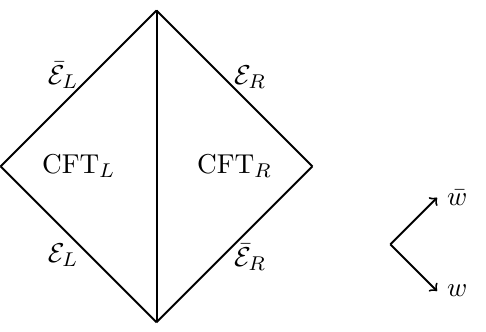
Figure 4 . The Penrose diagram associated to the defect CFT. Due to the non trivial gluing conditions, now E L and E R do not need to have the same expectation value in a generic state, and similarly for (cid:22) E L and (cid:22) E R . Energy can be